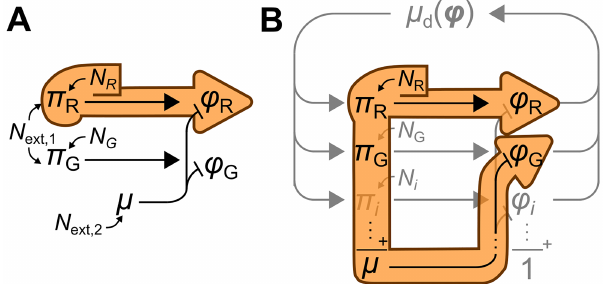
Fig 2. Limitations of the operational definition of in- and extrinsic expression noise. ( A ) Extrinsic noise is measured by the covariance between the expression levels of two identical reporter systems R and G. This presupposes that the intrinsic noise N R of system R affects concentration ϕ R but not ϕ G (orange outline), so that the covariance between ϕ R and ϕ G quantifies the contribution of extrinsic sources N ext, . ( B ) But in our model, N R affects the growth i rate and thus the dilution of ϕ G . This adds a negative term to the covariance, which no longer measures just the extrinsic